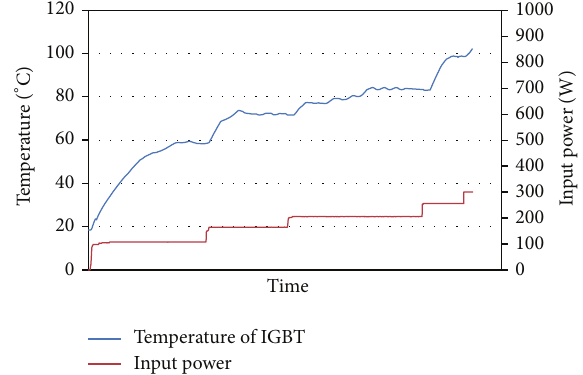
Figure 11: Dependence of temperature on input power of IGBT cooled by LHP with fourth variant of wick